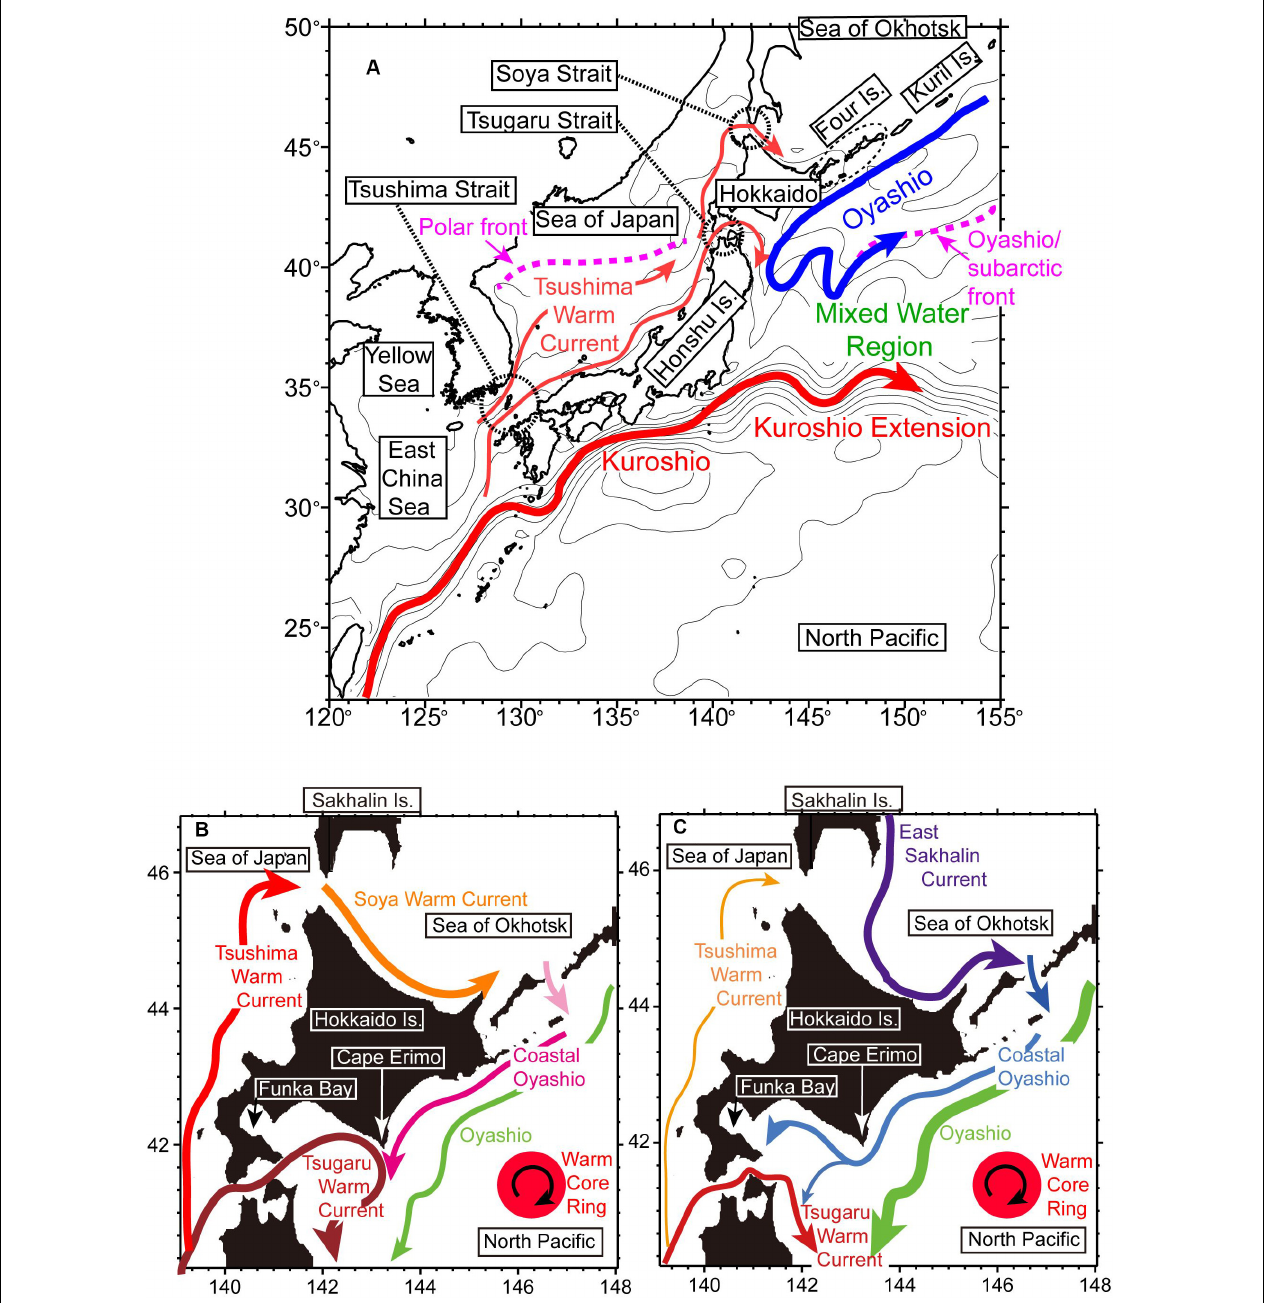
FIGURE 1 | (A) Schematic view of sea-surface currents around Japan. The Polar front in the Sea of Japan and the Oyashio/subarctic front in the North Pacific are indicated by pink bold dashed lines. Warm (cold) colors roughly represent warm (cold) water masses that are mainly transported by the currents. (B,C) Schematic views of seasonal sea-surface currents around Hokkaido during (B) summer–autumn and (C) winter–spring.